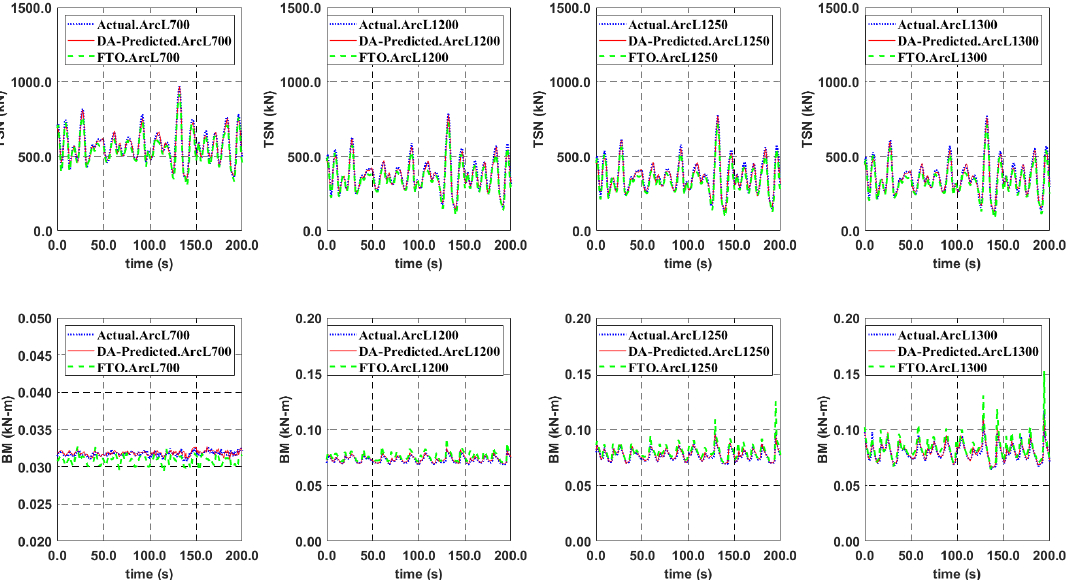
Figure A4. Tension Estimation up to Target Point, 100-yr storm (Down), WD1000, Sensor Interval = 100 m, Umbilical.